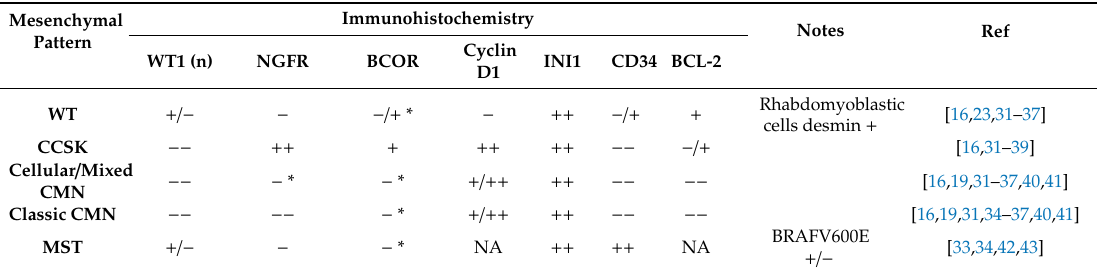
Table 3. The immunohistochemical characteristics of the most common pediatric renal tumors with a mesenchymal pattern.